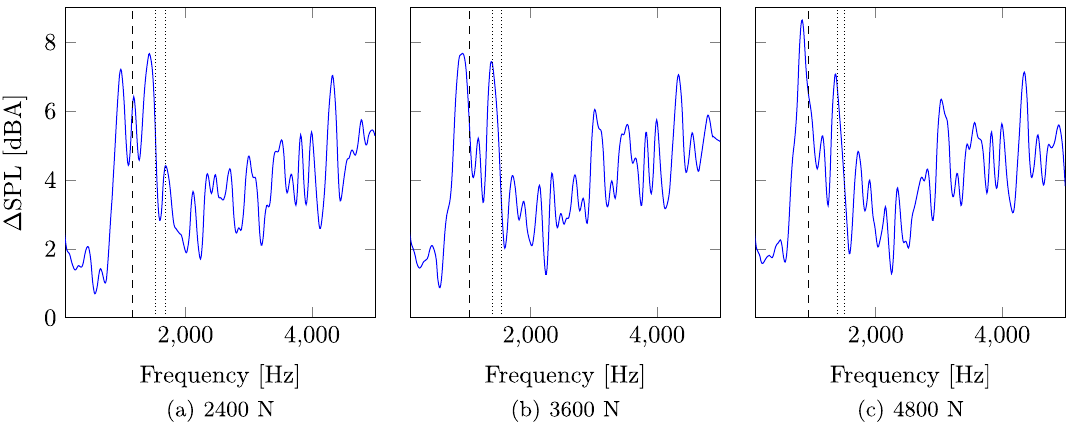
Figure 10. Comparison between the measured groove resonance ’ s spectrum and the computed groove resonance frequencies of the winter tire. The dashed line corresponds to the transverse resonance of the footprint (see Fig. 8a). The dotted lines depict the resonance frequency boundaries of the winter tire ’ s grooves (see Fig. 8b)